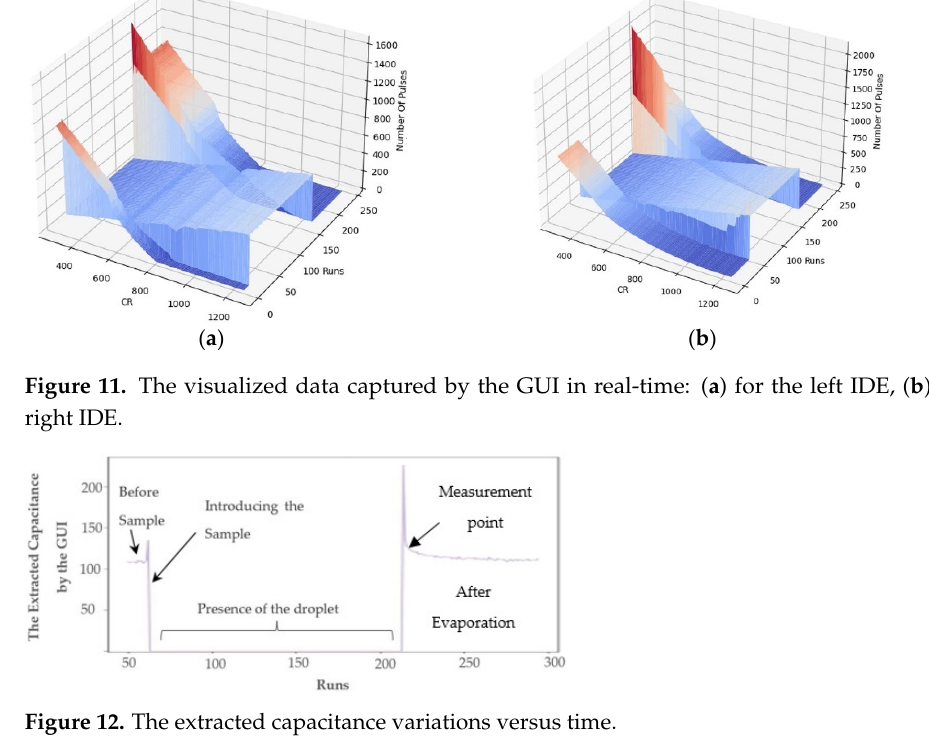
Figure 12. The extracted capacitance variations versus time.